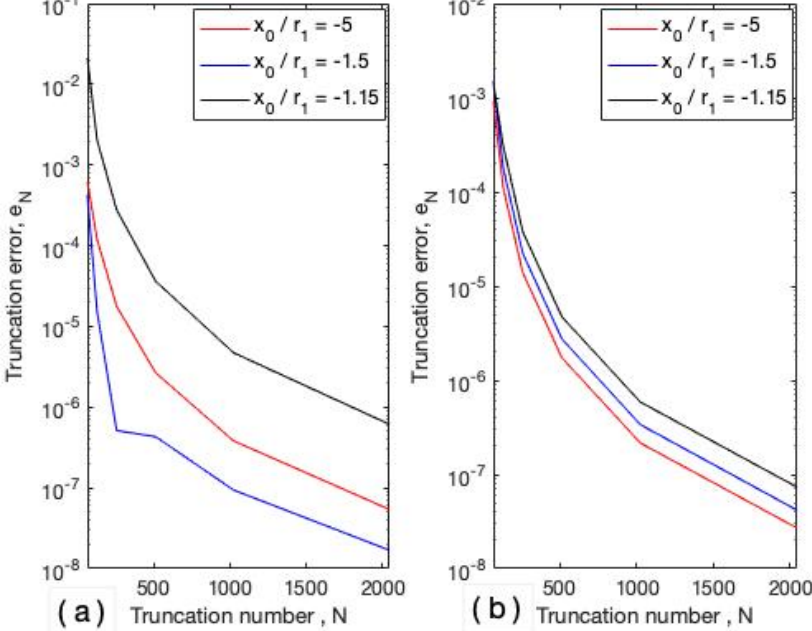
Figure 2. Relative truncation error e N versus truncation number N for a slotted circular cavity at the different relative locations x 0 / r 1 of the rod, r 2 / r 1 = 0.1, kr 1 = 2 π (so r 1 = λ ), with slit widths: ( a ) w / r 1 = 2sin π /12 ≈ 0.5176; ( b ) w / r 1 = 2sin π /6 =